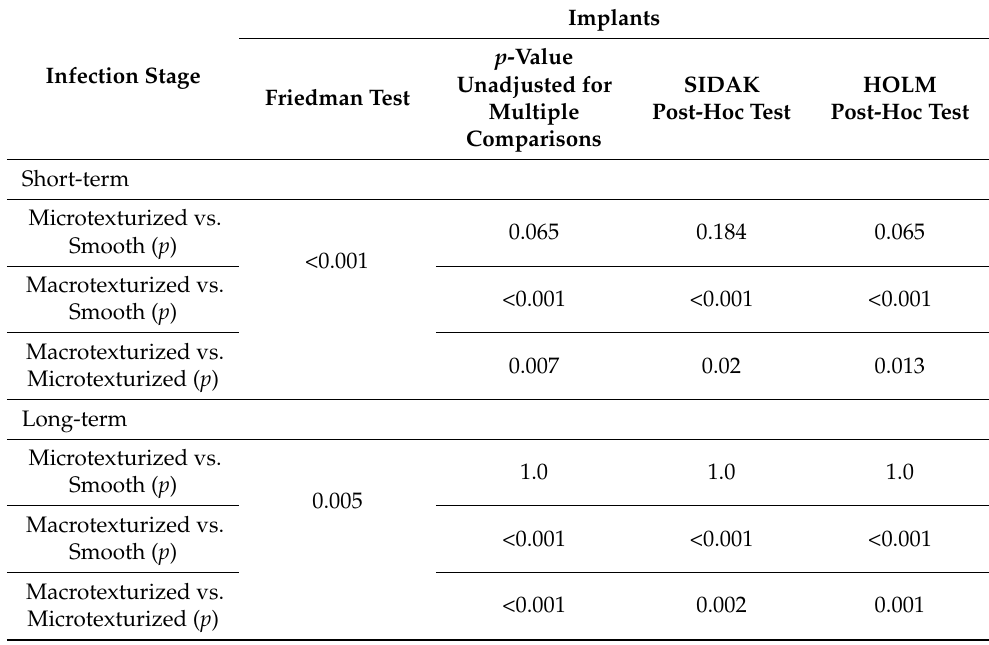
Table 3. Adjustment of p -values for multiple comparisons of each implant by Holm test and SIDAK post hoc test.